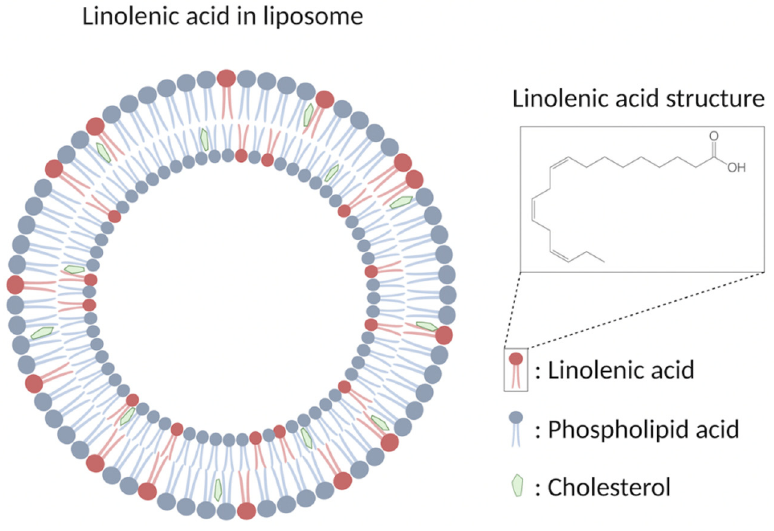
Figure 2. Schematic drawing showing the structure of